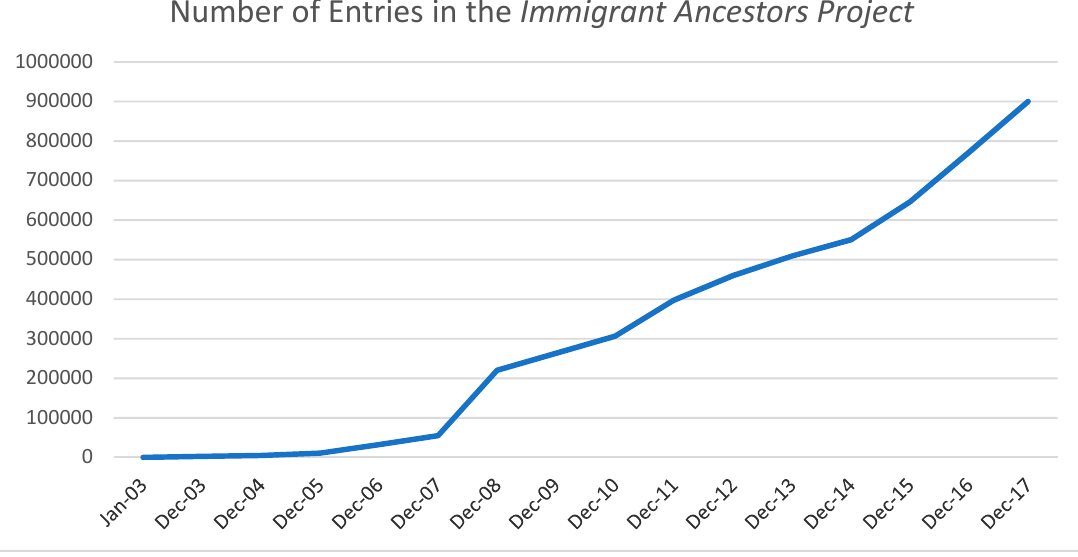
Figure 5. Chart showing the number of names in the IAP database from 2003 to 2017.